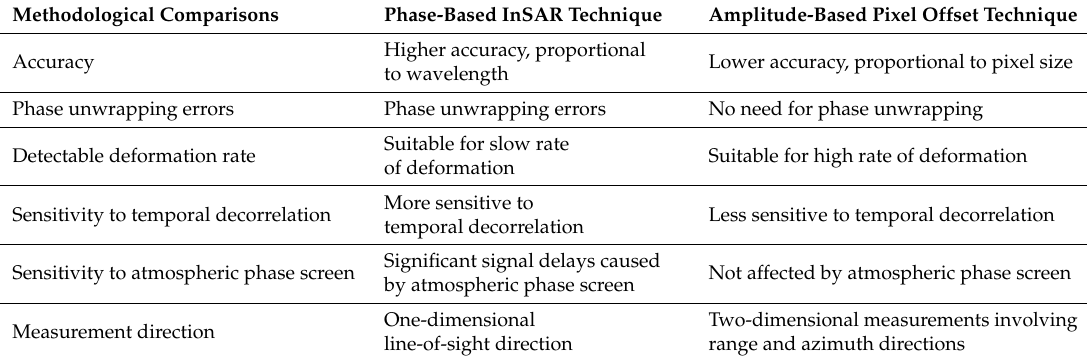
Table 1. Comparison of the phase-based InSAR technique with the amplitude-based pixel offset